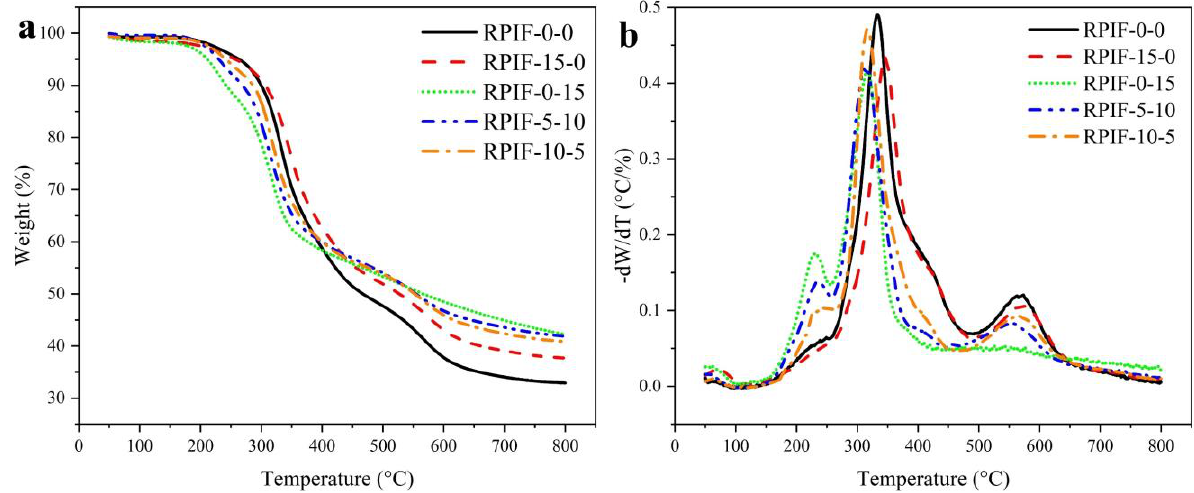
Figure 6. TGA ( a ) and DTG ( b ) curves of